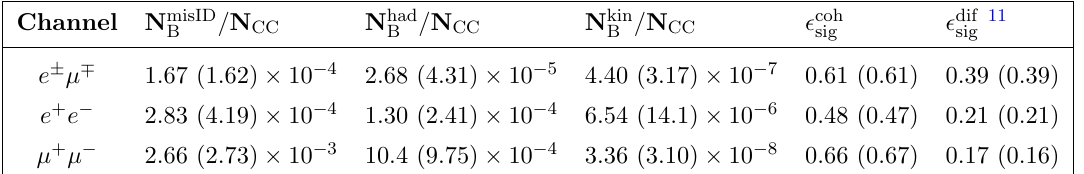
Table 5 . Reduction of backgrounds at the DUNE ND in neutrino (antineutrino) mode and its impact on the signal for each distinguishable trident (cid:12)nal-state. N misID stands for total backgrounds B to trident after only applying misID rates, N had are the backgrounds after the hadronic veto, and B N kin reduce the latter with detection thresholds and kinematical cuts (see text for the cuts chosen). B These quantities are normalized to the total number of CC interactions in the ND N CC ((cid:13)avour inclusive). We also show the impact of our detection thresholds and kinematical cuts on the trident signal via e(cid:14)ciencies for coherent only ( (cid:15) coh ) and di(cid:11)ractive only samples ( (cid:15) dif ). We do not cut on sig sig the hadronic activity of di(cid:11)ractive